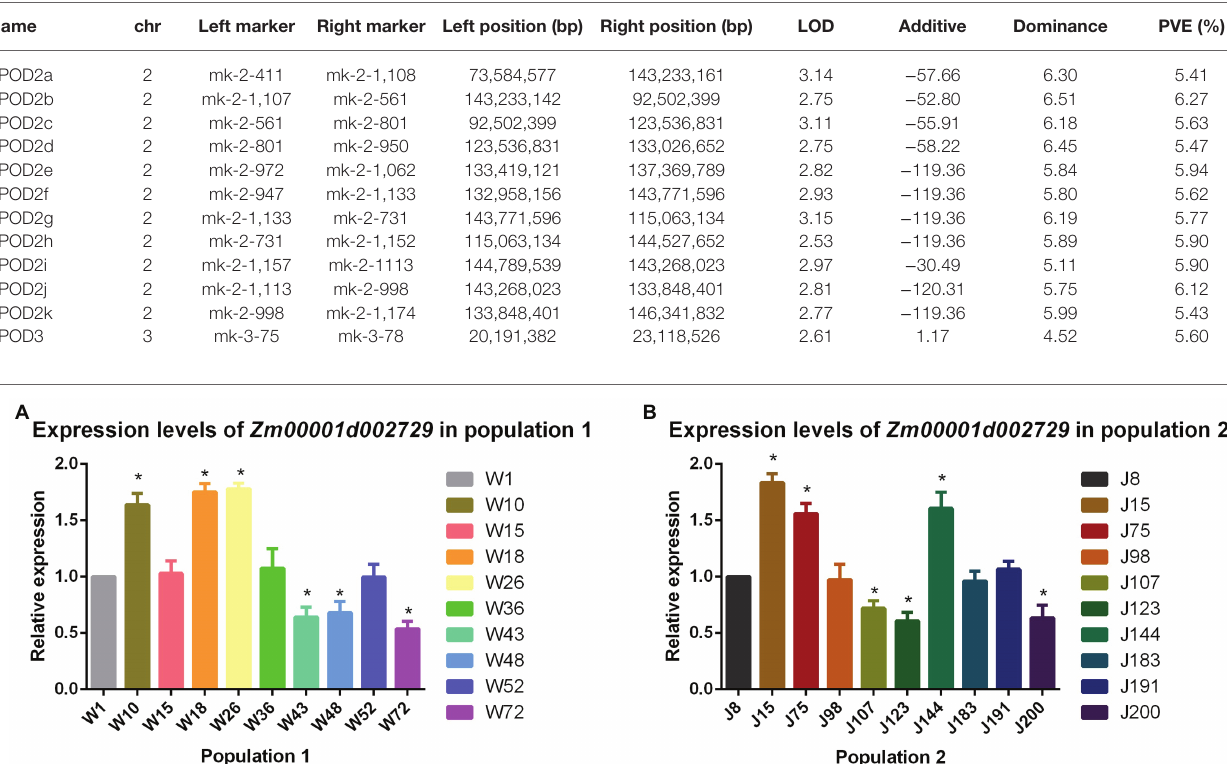
TABLE 2 | Quantitative trait locus (QTLs) associated with POD